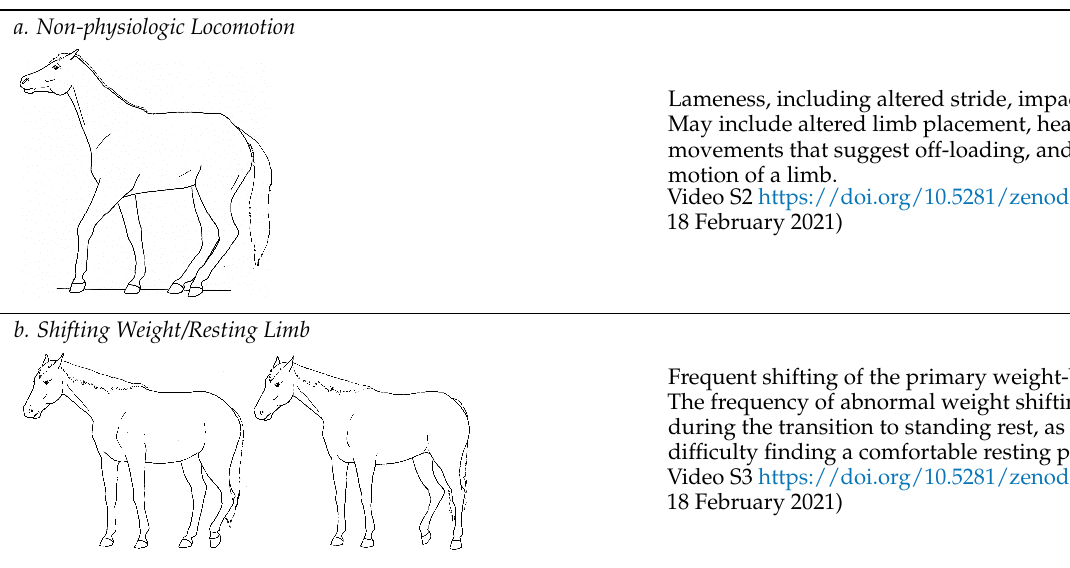
Table 1. Posture and weight-bearing.